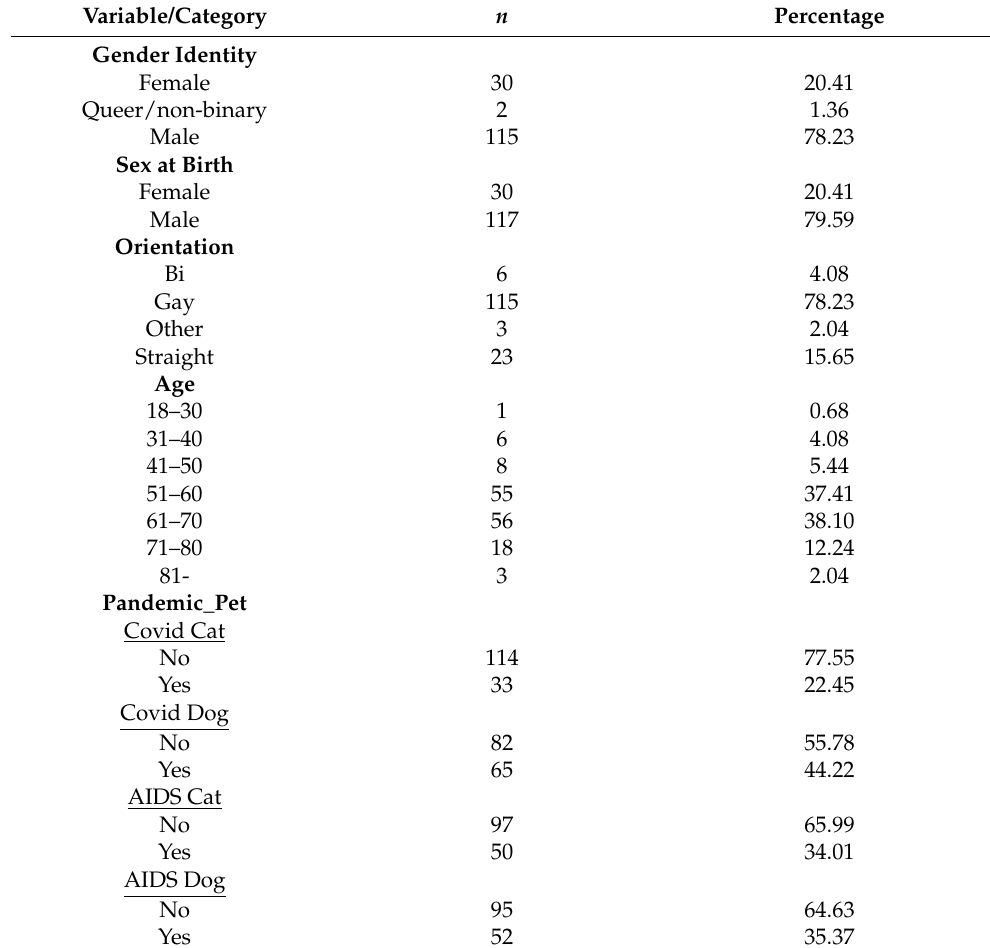
Table 1. Demographics of